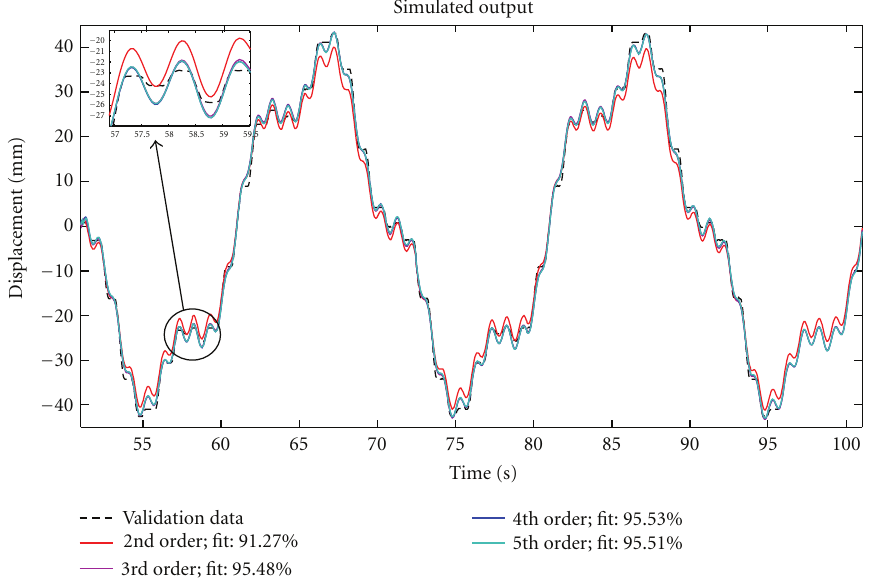
Figure 3: Model validation using best fitting criterion.